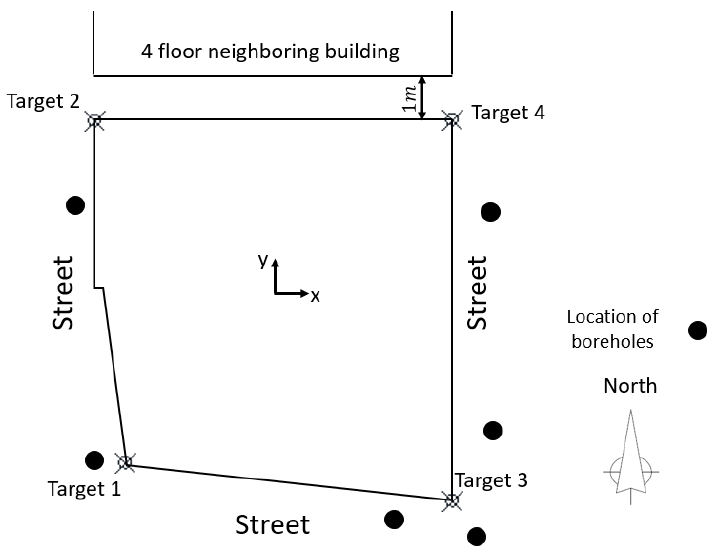
Figure 1. Layout of the building under investigation.